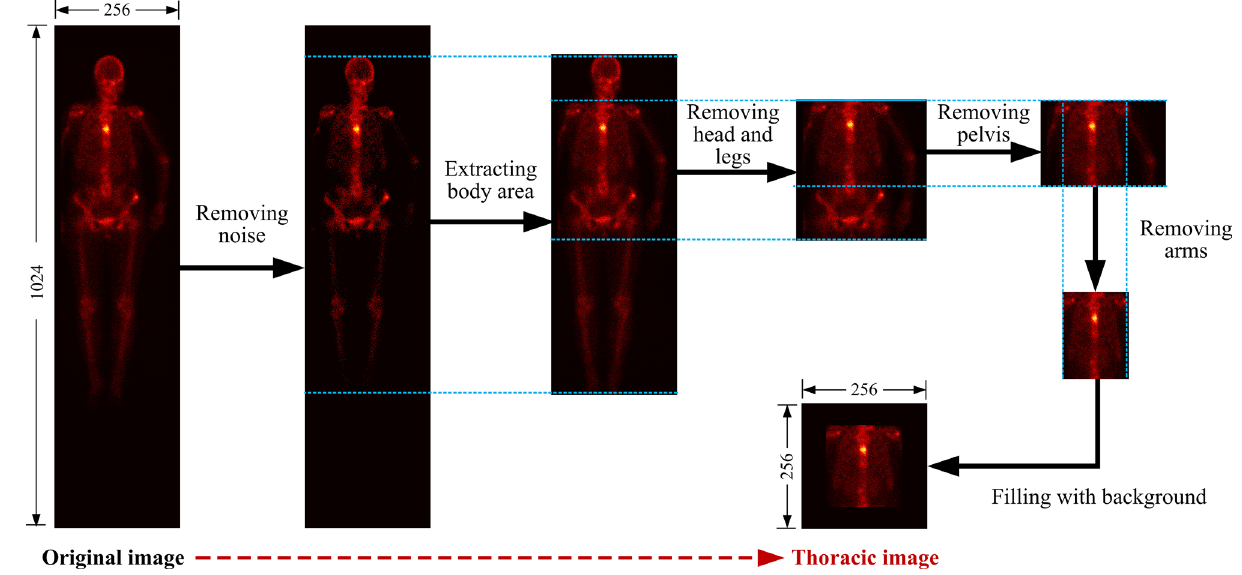
Figure 2. The process of cropping a 256 × 256 thoracic region from the original 256 × 1024 whole-body SPECT bone image.